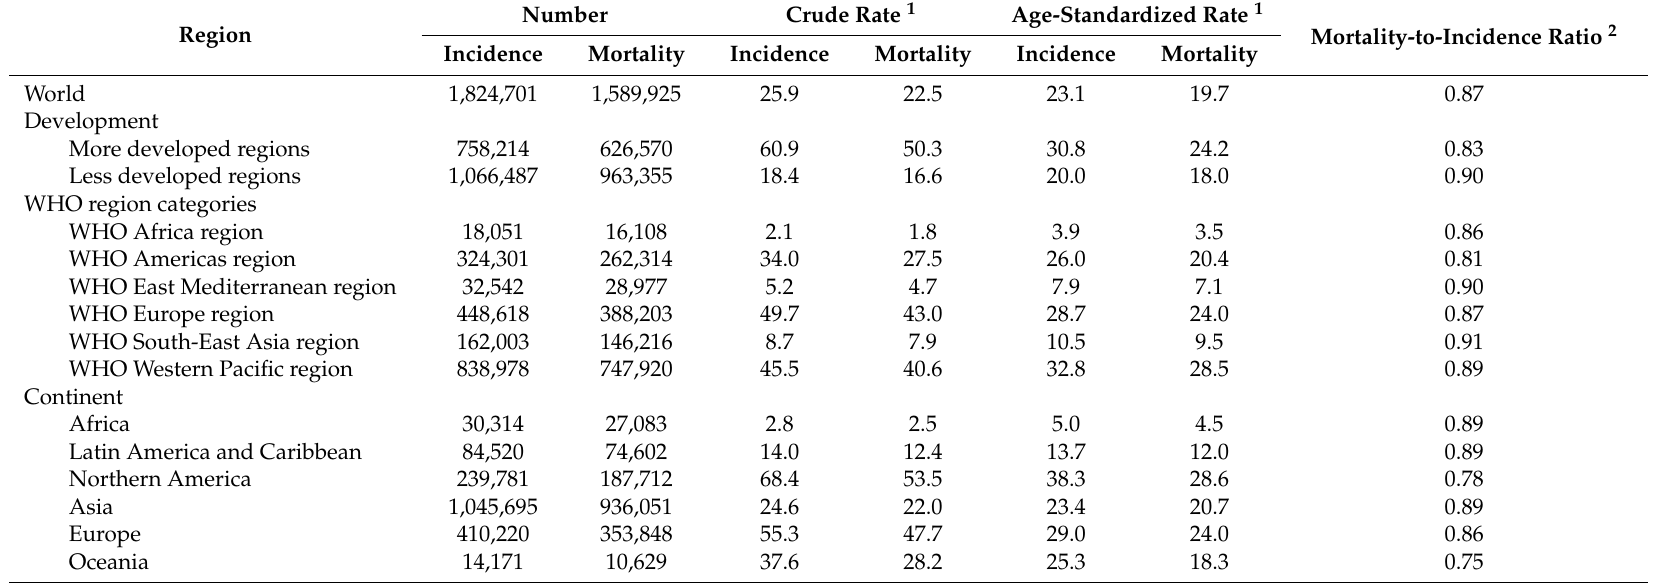
Mortality-to-Incidence Ratio 2